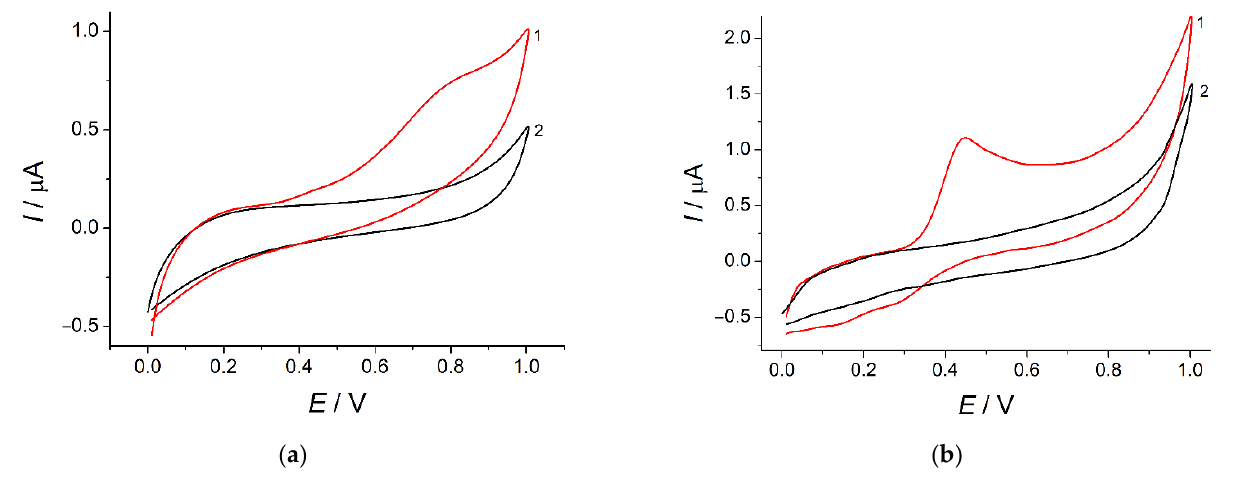
Figure 3. Cyclic voltammograms of 50 µM indigo carmine (curve 1) in PB pH 7.0 (curve 2): ( a ) bare GCE; ( b ) SeO 2 –CPB/GCE. Potential scan rate is 100 mV s –1 .